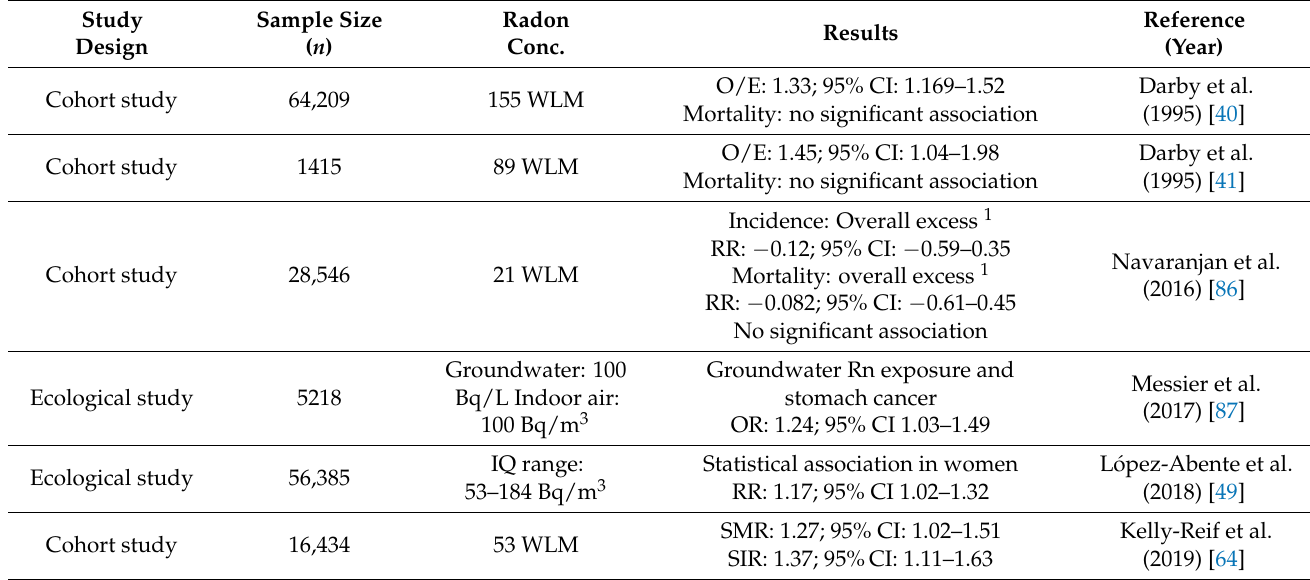
Table 4. Stomach cancer: Workers and General